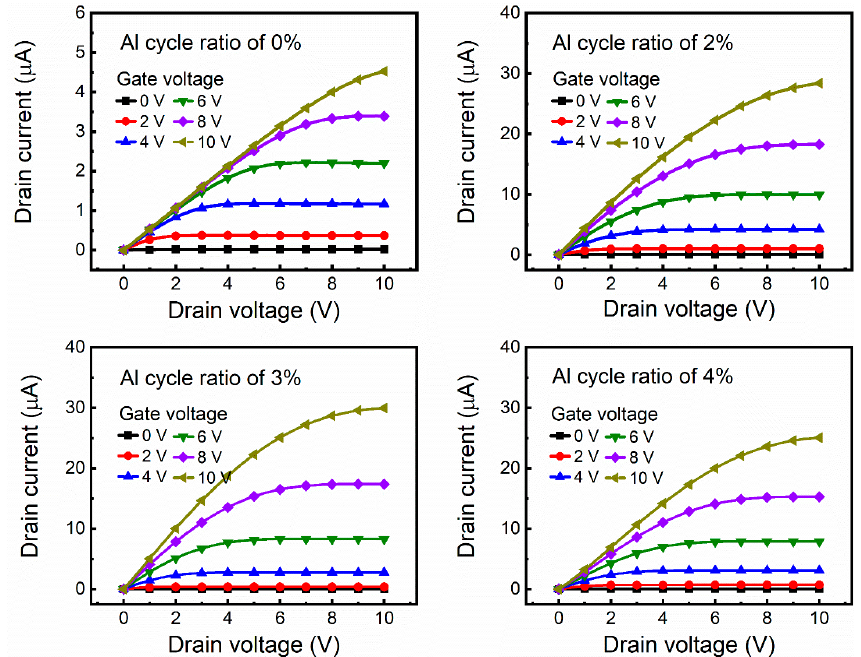
Figure 10. I D –V D curves of ZnO TFTs. ZnO and AZO films are used as S/D electrode.